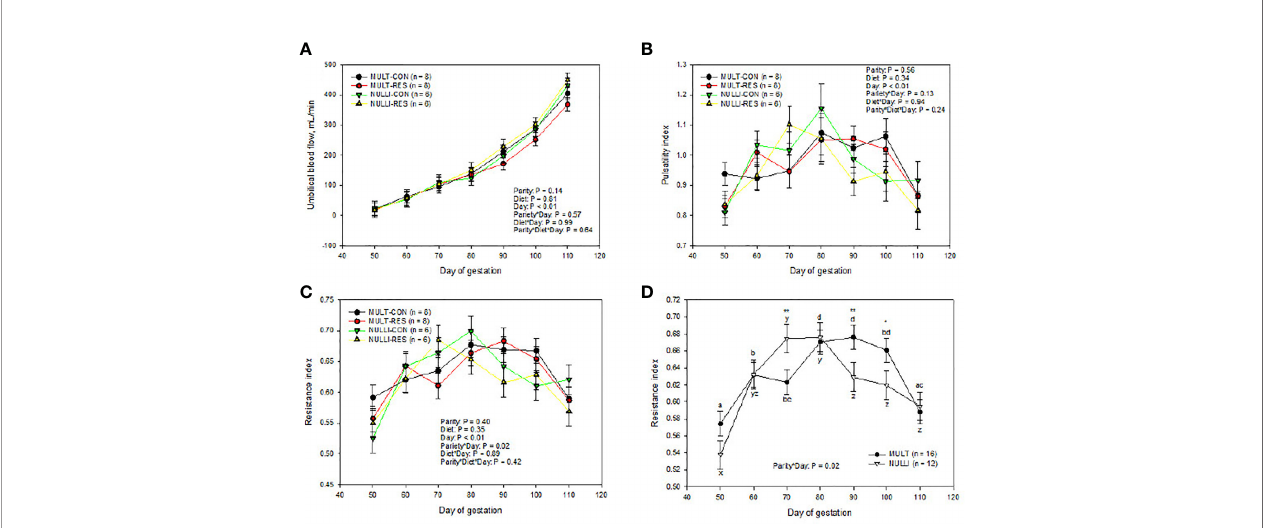
FIGURE 4 | Impacts of maternal nutrition on fetal umbilical blood fl ow (A) , umbilical pulsatility index distance (B) , and umbilical resistance index (C, D) from days 50 to 110 of gestation in multiparous (MULT) and nulliparous (NULL) ewes. CON = 100% of NRC recommendations. RES = 60% of CON from days 50 to 90 of gestation. abcd LSMEANS ± SEM between days differ P ≤ 0.05. Differences between CON and RES are denoted by **P ≤ 0.05, *P ≤ 0.10 within a